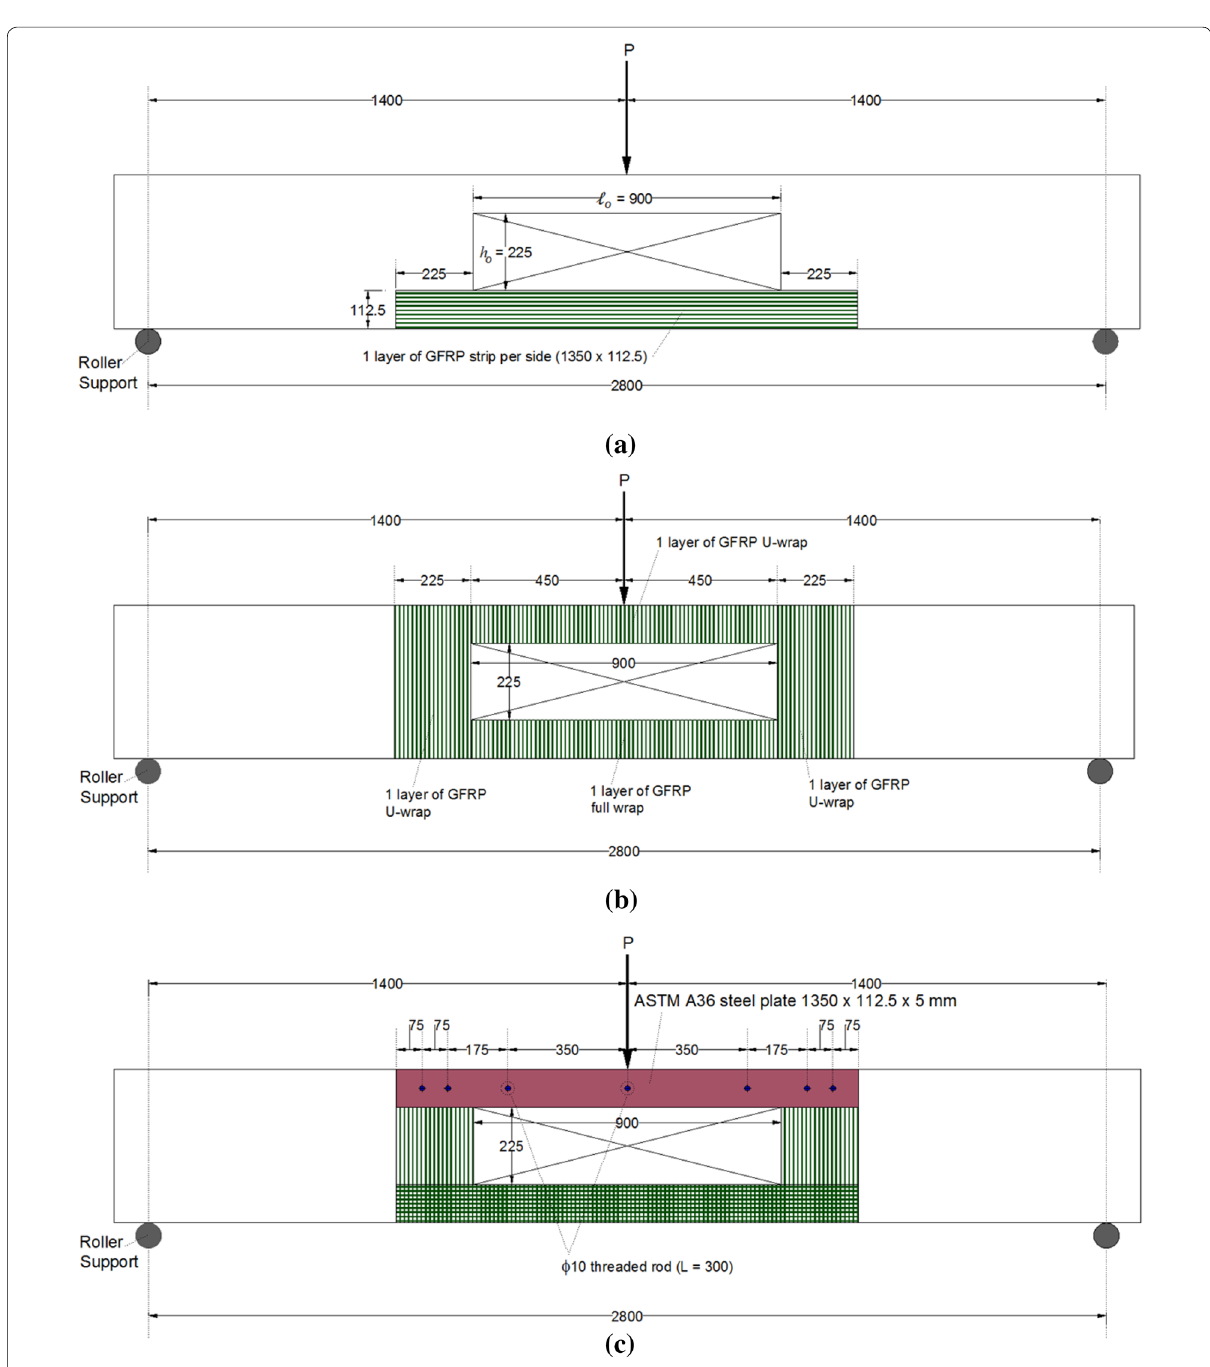
Fig. 6 Details of strengthening scheme‑2 for specimen BS2‑O2‑CPL (Note: all dimensions are in mm): a 1st GFRP layer, b 2nd GFRP layer, and c steel